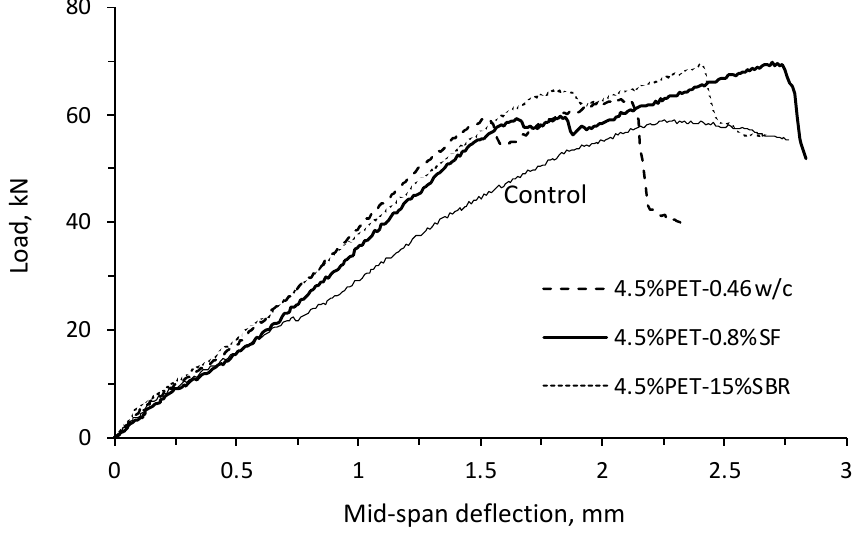
Figure 9. Effect of concrete modification on the load vs. mid-span deflection curves for the 4.5% PET-modified RC beams (i.e., shear testing).